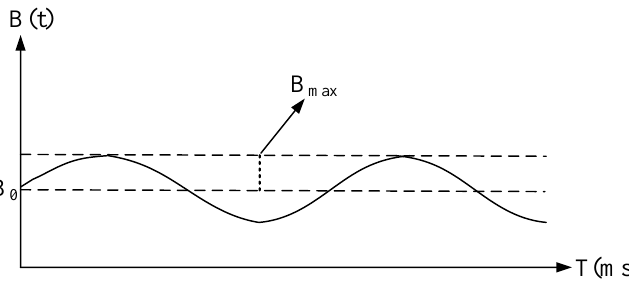
Figure 3. The waveform of the mixed magnet.